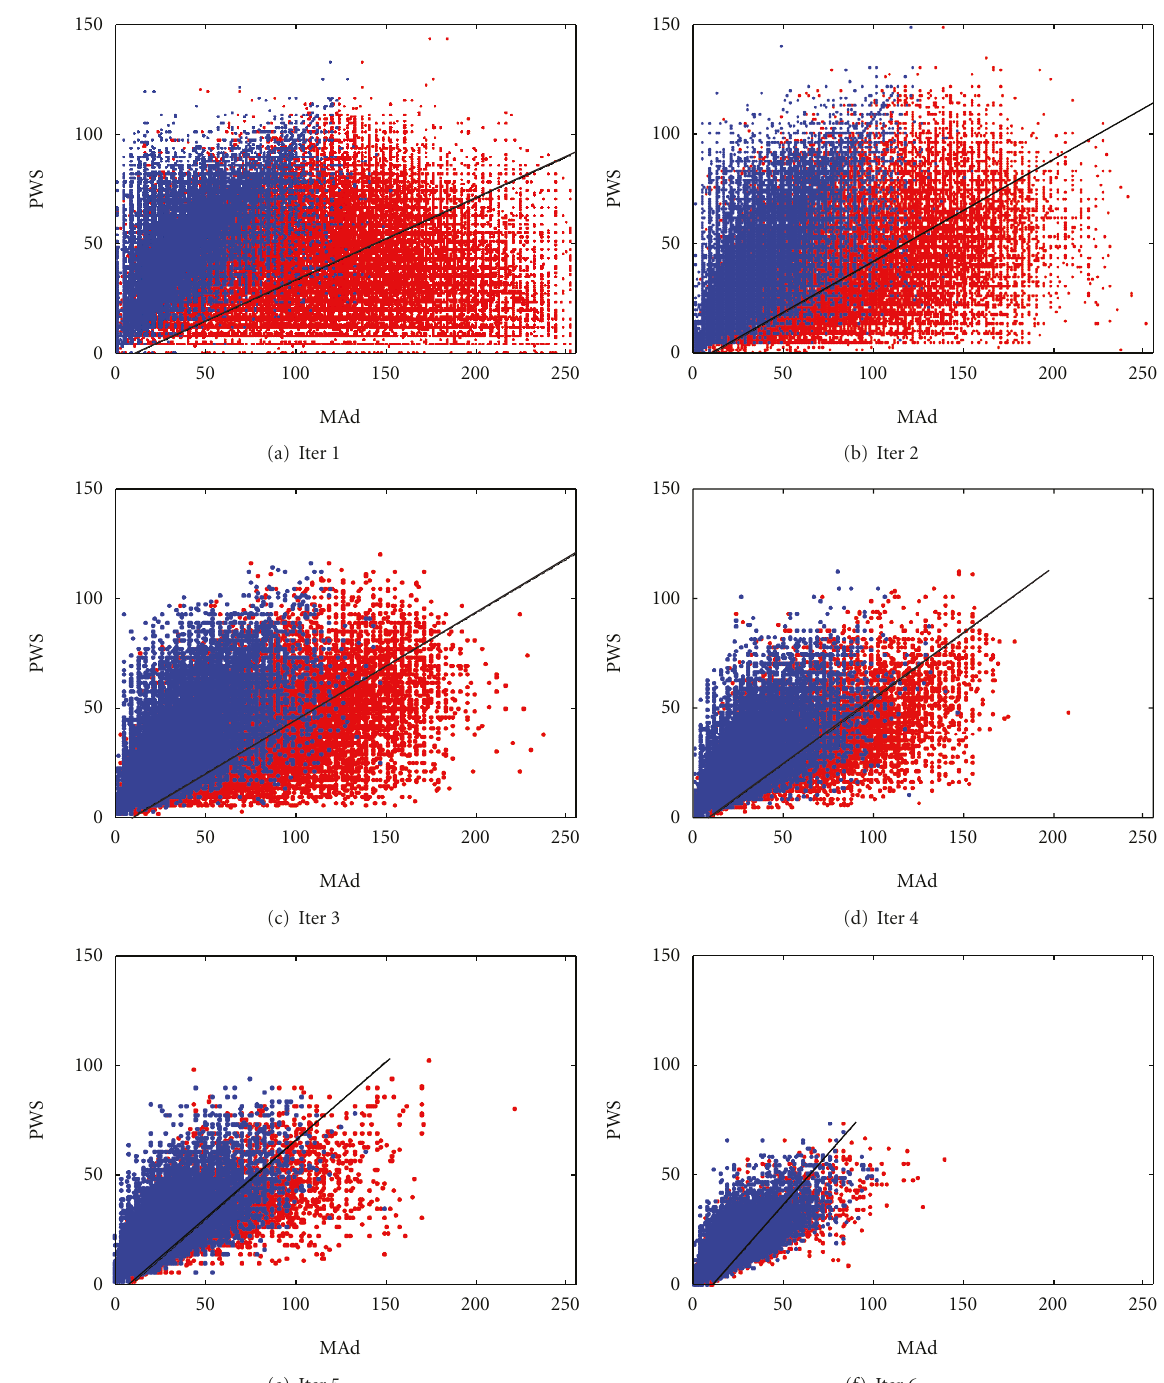
Figure 4: Scatter plots of noisy and noise-free pixels for the image Bridge corrupted with 40% mixed impulse noise. Each plot displays the distribution of noisy and noise-free pixels together with the classification